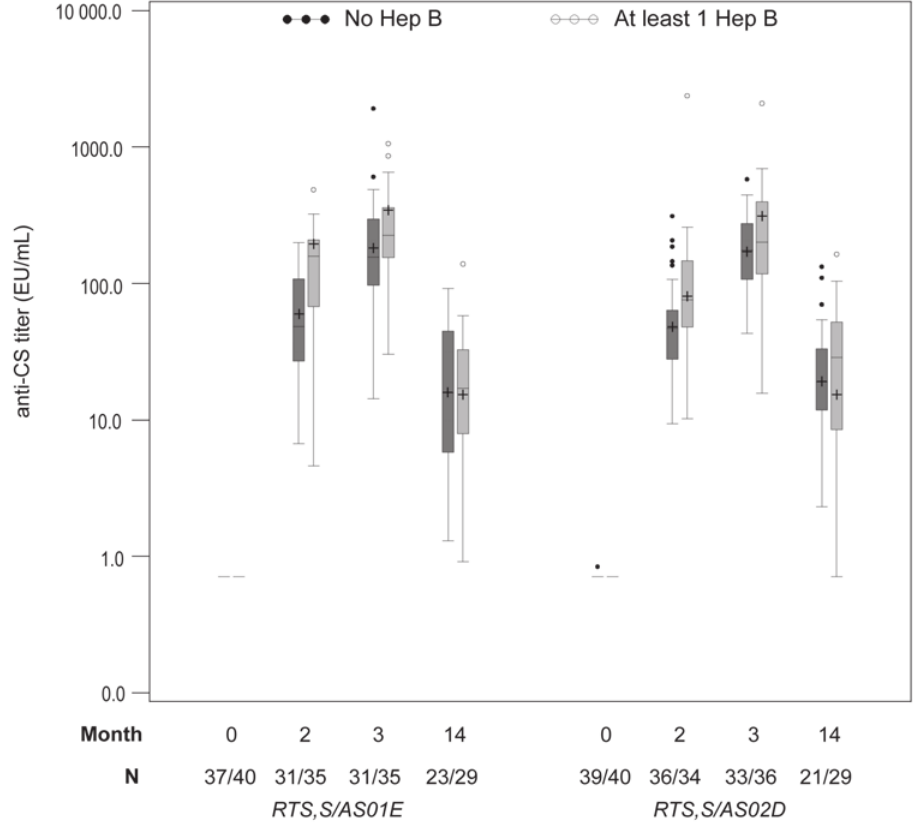
Figure 2. The effect of previous hepatitis B vaccination on anti-CS antibodies. Boxplot graph of anti-CS responses. Represents Q25, median, Q75, highest and lowest observation below/above 1.5 times interquartile range and individual data points below/above 1.5 times interquartile range. GMTs are indicated by + .